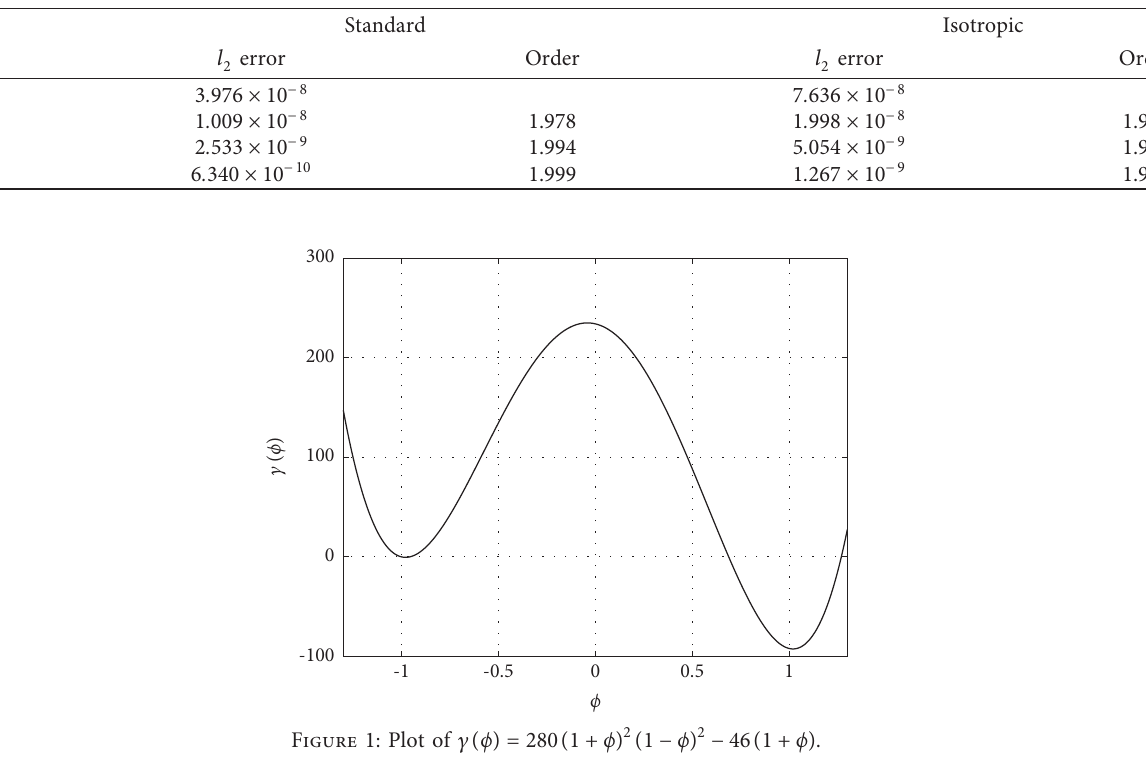
Table 1: l -norm of the errors and convergence rates of standard and isotropic schemes. 2